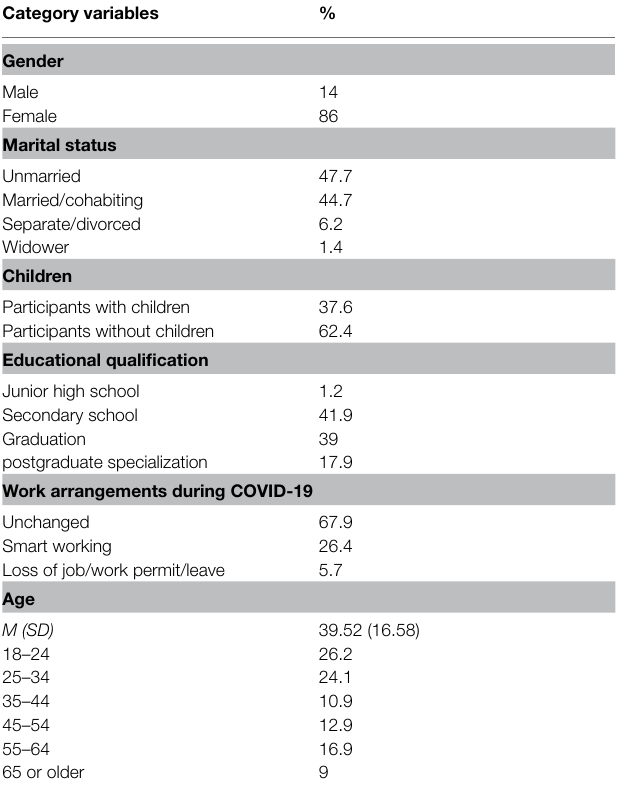
TABLE 2 | Fear of COVID-19 scale: comparison between the average values of the participants and the average values of the Italian normative sample (Servidio et al., 2021).